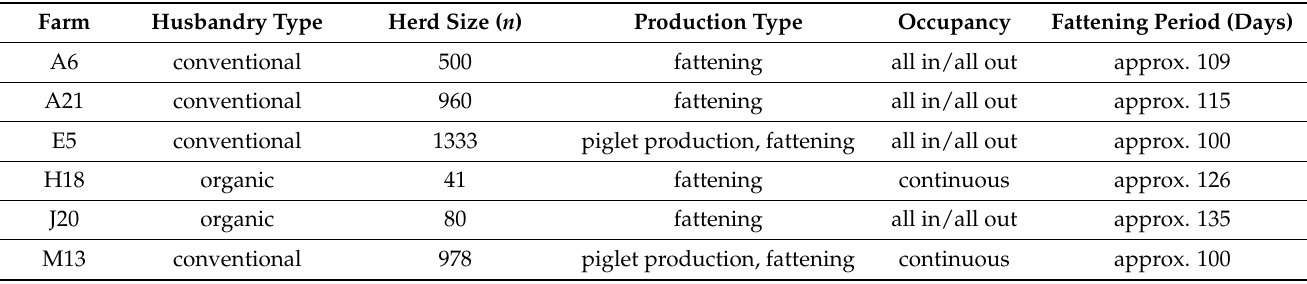
Table 1. Characteristics of included